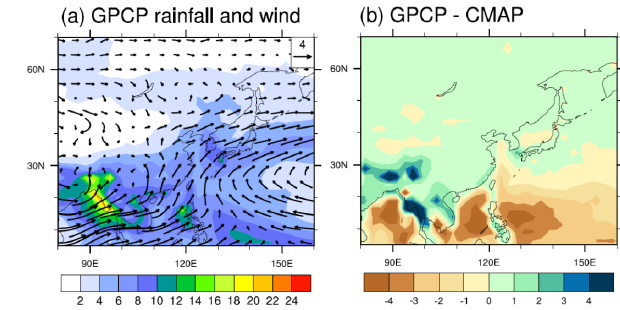
Figure 1. The 1982–2005 JJA (a) climatology of the Global Pre- cipitation Climatology Project (GPCP) precipitation (mmday − 1 , shading) and 850hPa winds (ms − 1 ) and (b) precipitation differ- ence between GPCP and the CPC Merged Analysis of Precipitation